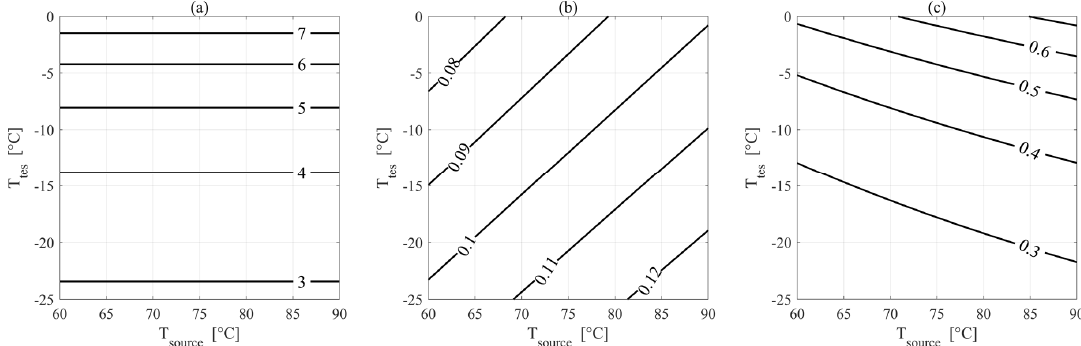
Figure 9. “Hot TI-PTES” performance parameters in terms of heat source temperature T source and TES temperature T tes . ( a ) VCHP COP ; ( b ) ORC η ; ( c ) TI-PTES ε rt .